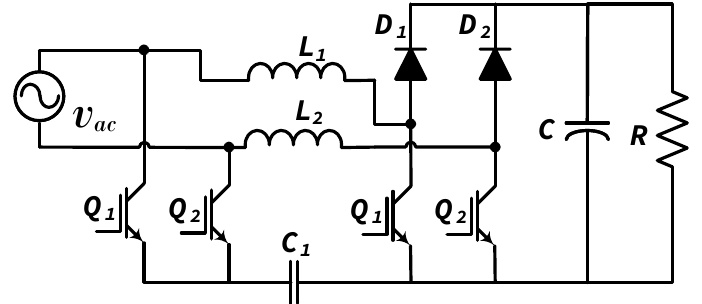
Figure 11. Semi-bridgeless boost converter with clamped